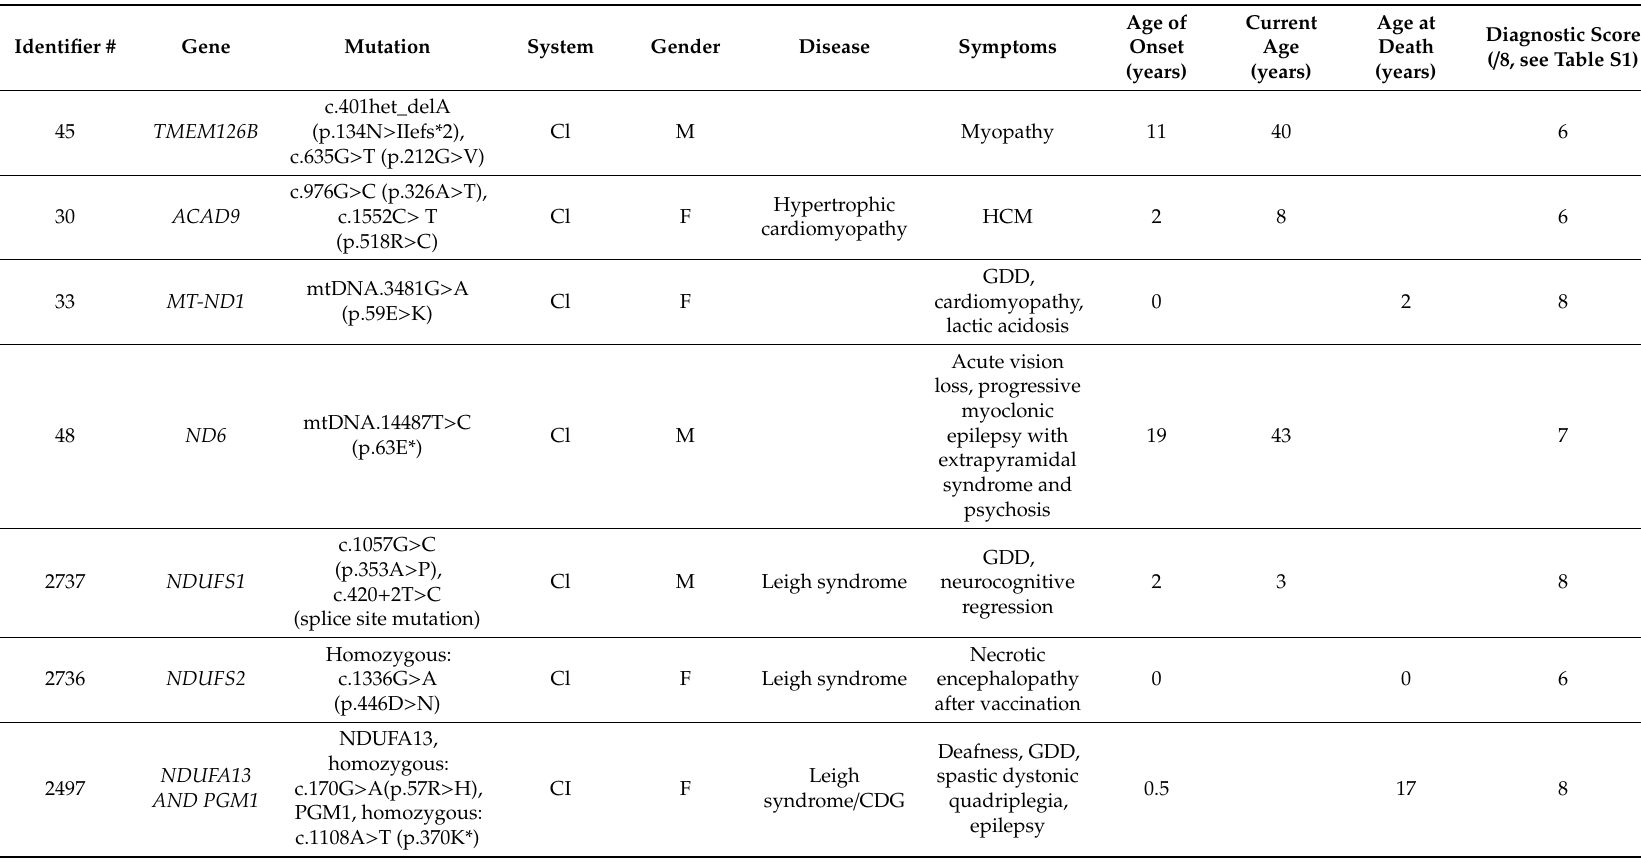
Table 1. PMD patient characteristics. Abbreviations: CI–CV, OXPHOS complexes I–V; CDG, congenital disorder of glycosylation; CKD, chronic kidney disease; Com, combined; DM, diabetes mellitus; F, female; GDD, global developmental delay; HCM, hypertrophic cardiomyopathy; LTBL, leukocencephalopathy with thalamus and brainstem involvement and high lactate + ; M, male; MIU, mors in utero; NALF, neonatal acute liver failure; ND, no data; PEO( + ), progressive external ophtalmoplegia (with accompanying